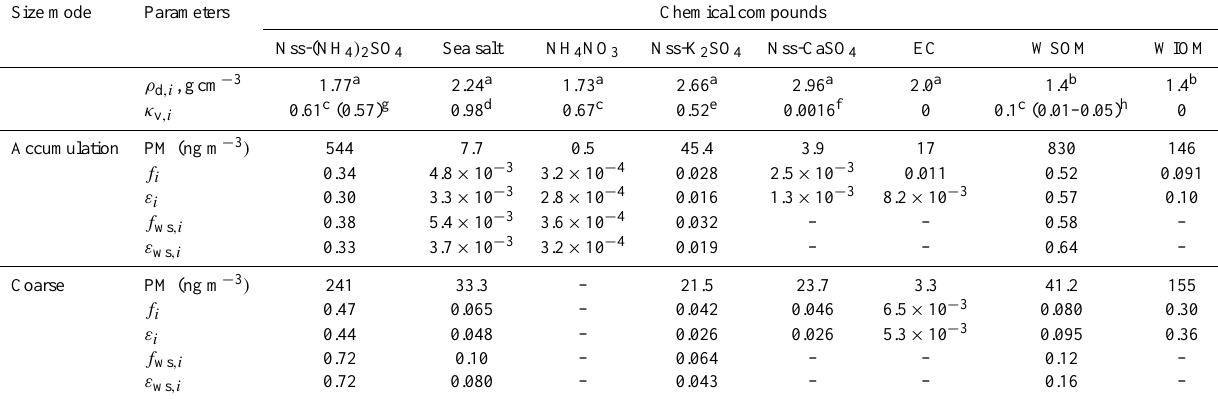
Table 4. Reconstructed neutral species concentrations (ng m − 3 ) in the accumulation (0.1–1µm) and coarse (>1µm) size modes, their mass fraction ( f i ) , volume fraction ( ε i ), density ( ρ d ,i ) , and CCN-derived hygroscopicity ( κ v ,i ) . The κ v ,i values in brackets were obtained under subsaturated conditions in the 96–99.4% RH range. Uncertainties of all parameters for inorganic and carbonaceous compounds are estimated to be ∼ 10 and ∼ 30%, respectively. The subscript ws stands for parameters related to the water-soluble